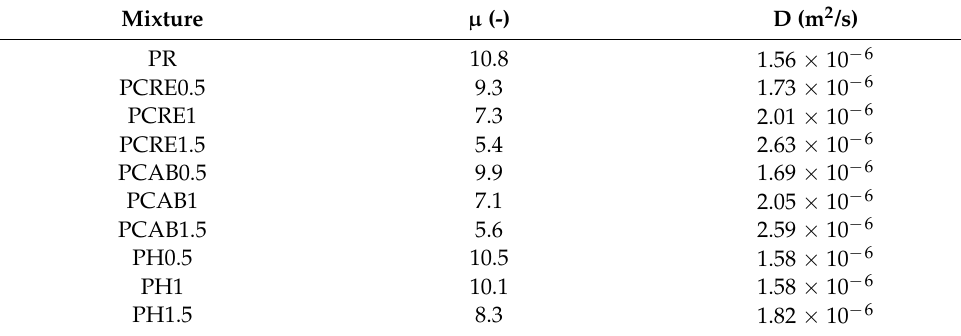
Table 6. Water vapor diffusion properties of studied